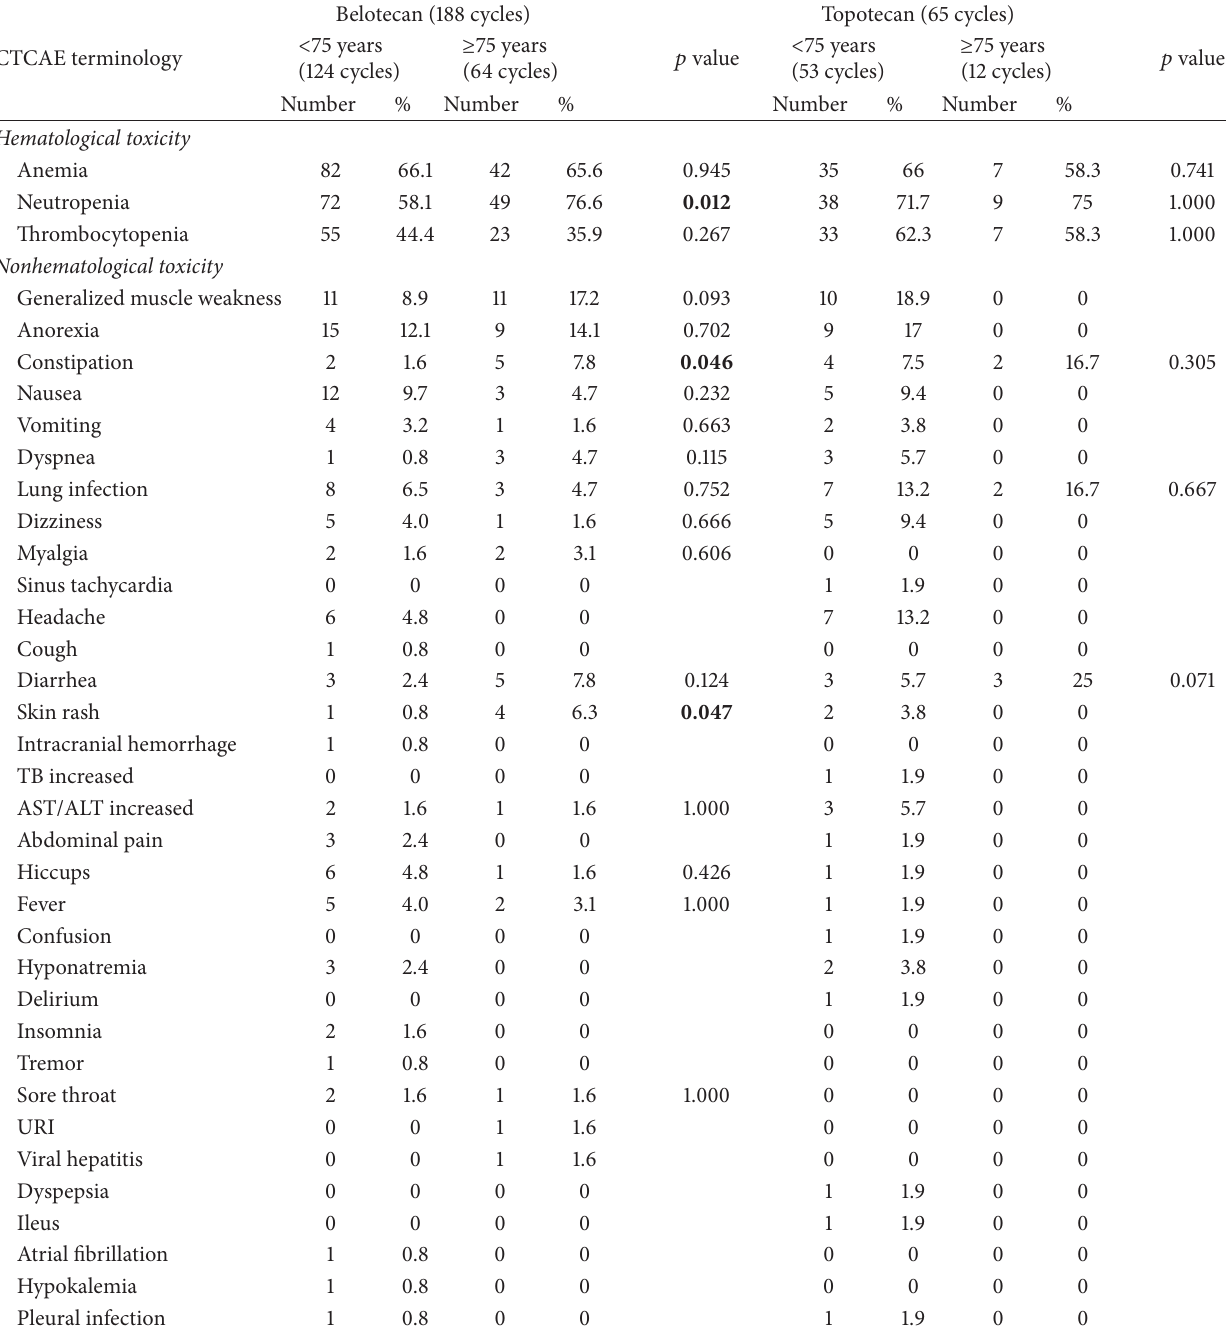
Table 4: Comparing the toxicities for patients who were < 75 years or ≥ 75 years